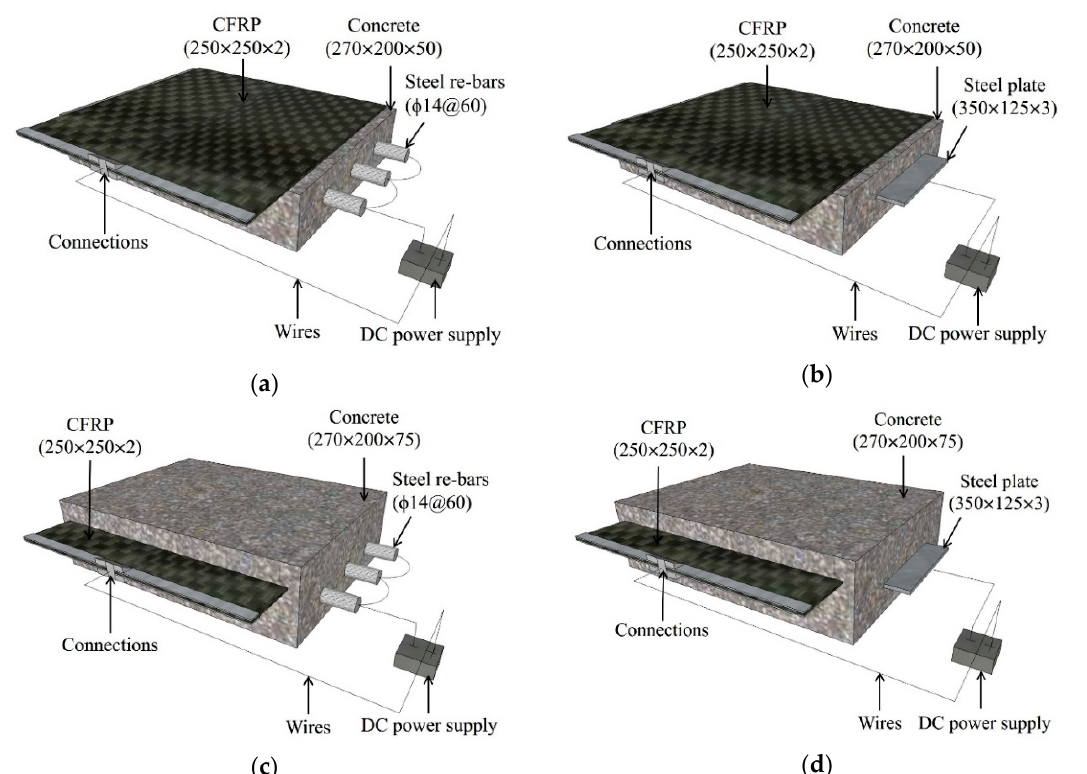
Figure 1. Schematic diagrams of the chloride-contaminated concrete test specimens with bonded carbon fiber reinforced polymer (CFRP) and embedded steel (all dimensions are in mm): ( a ) Steel rebars — externally bonded CFRP (B-EB specimens); ( b ) Steel plate — externally bonded CFRP (P-EB specimens); ( c ) Steel rebars — internally bonded CFRP (B-IB specimens); ( d ) Steel plate — internally bonded CFRP (P-IB specimens).